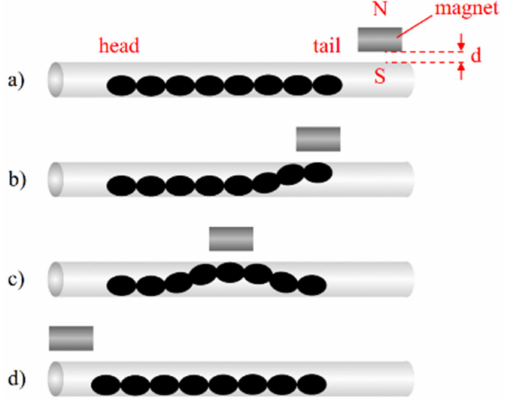
Figure 4. Mechanism of caterpillar locomotion. ( a ) The robot in resting state before actuation. ( b ) The ellipsoid units at the tail of the robot are lifted to form a half-wave. ( c ) Ellipsoid units of robot are lifted sequentially as the magnet move from tail to head. ( d ) Robot advances forward due to formation and movement of half-wave from the tail to the head. d is the separation between the magnet and the pipe surface.